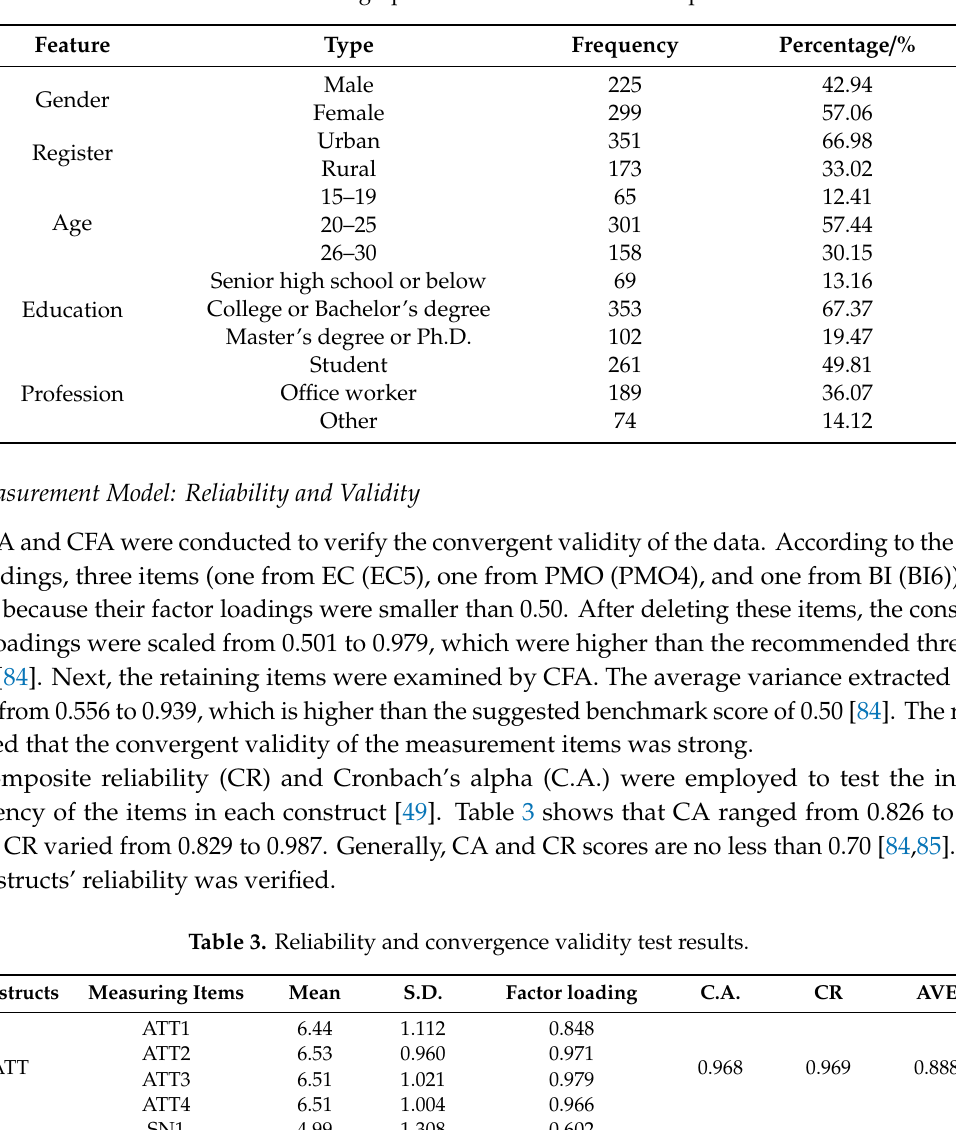
Table 2. Demographic characteristics of the sample.